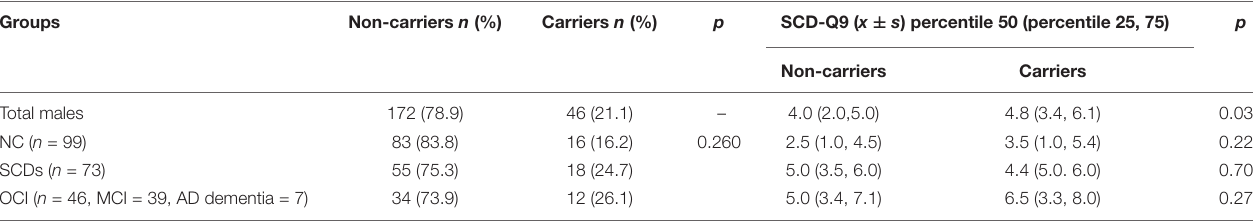
TABLE 5 | Distribution of APOE ε 4 and SCD-Q9 scores of carriers and non-carriers in NC, SCDs, and OCI groups in males.